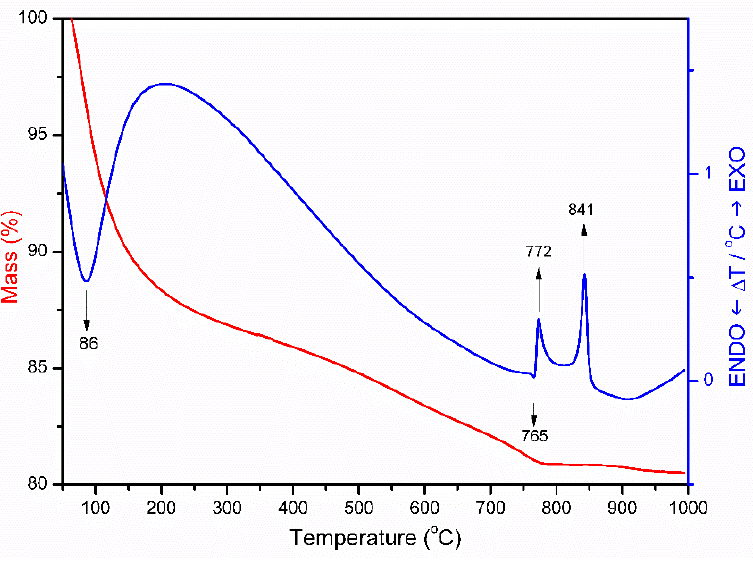
Figure 3. DTA–TG curves of sample SCA.